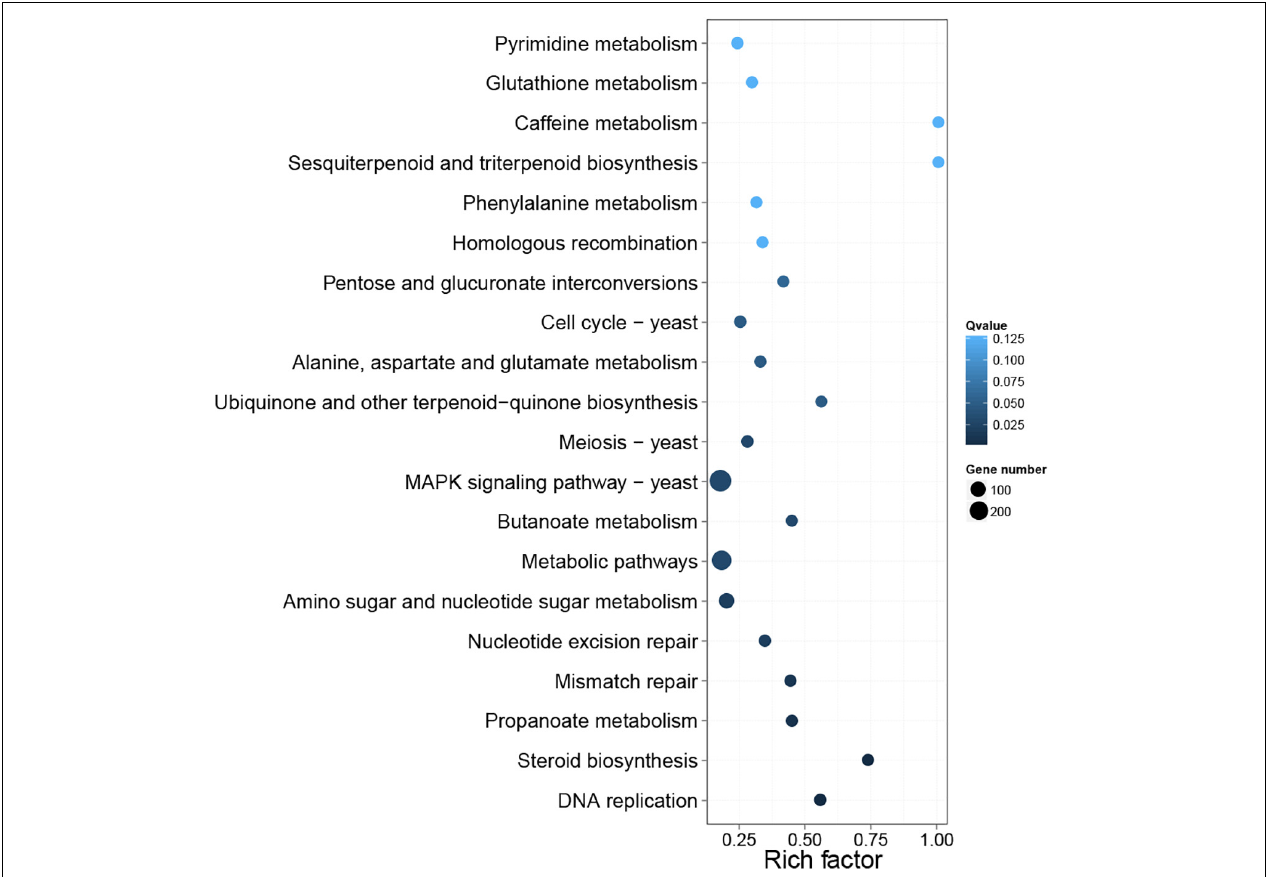
FIGURE 6 | Top 20 differential gene pathway enrichment results. The X-axis represents the enrichment factor value, and the Y-axis represents the pathway name. Color represents the Q value, with smaller values representing more significant enrichment results. The size of the dots represents the number of DEGs. Rich factor refers to the enrichment factor value, and a larger value indicates a more pronounced enrichment